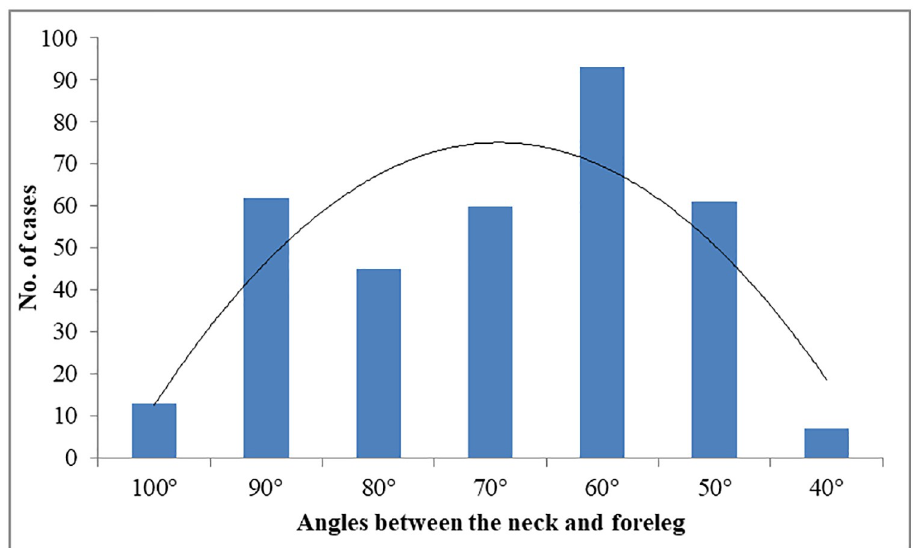
Fig 2. Posture expression of Puppet behavior of Tibetan